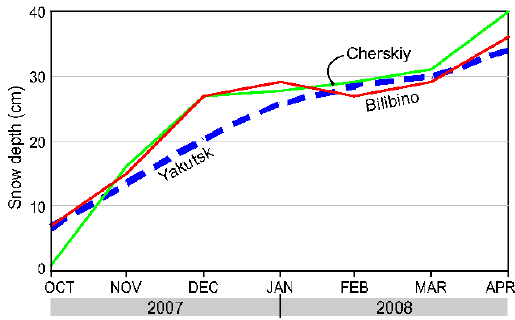
Fig. 4. Location of biomass fires based on the MODIS Fire Mapper (Giovanni program) for March–April of 2008. The resolution of the fire radiative power field (units of MW) is 1 ◦ × 1 ◦ .